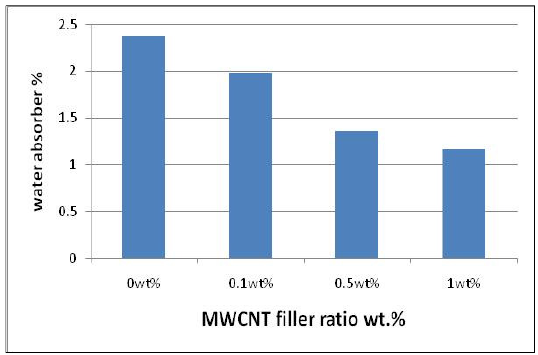
Fig. 14. result of water absorber for the nanocomposites with different MWCNT